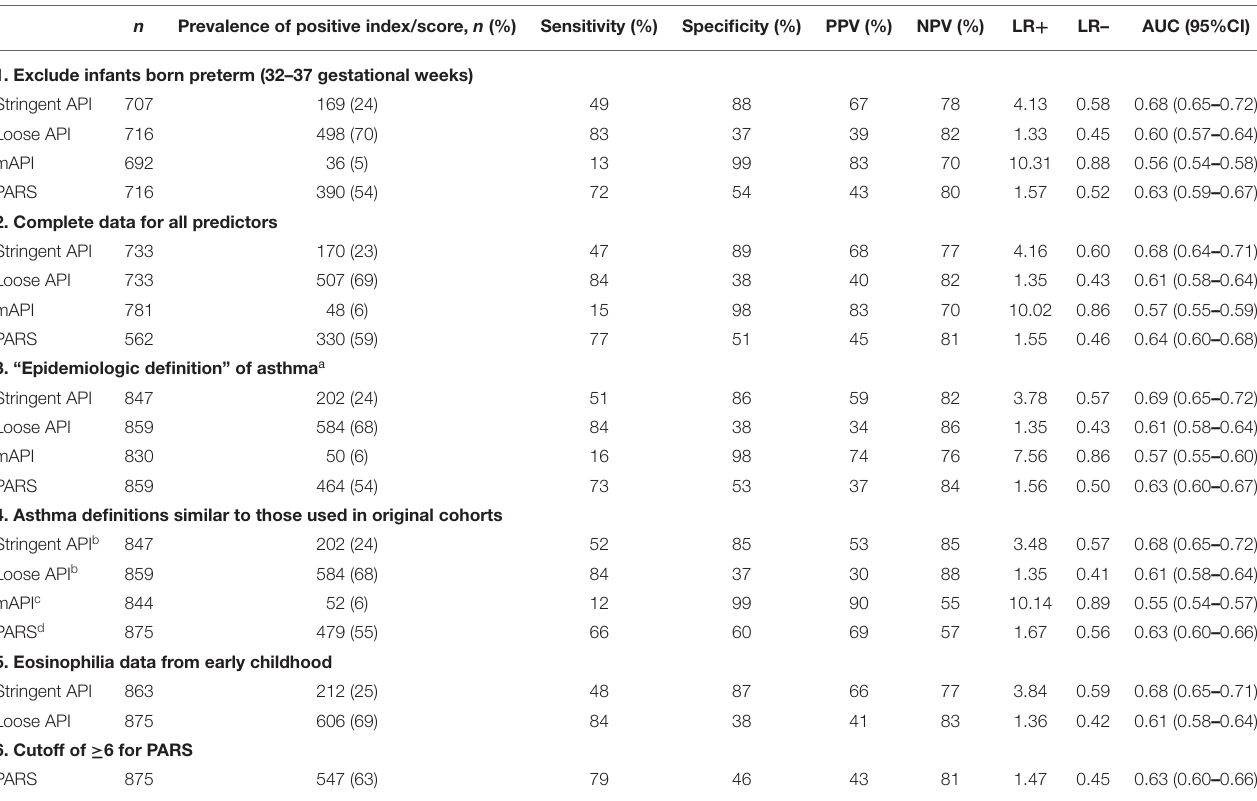
TABLE 3 | Test characteristics of API, mAPI, and PARS predicting asthma development at age 5 years among children hospitalized for bronchiolitis during infancy (MARC-35 cohort), in six sensitivity analyses.